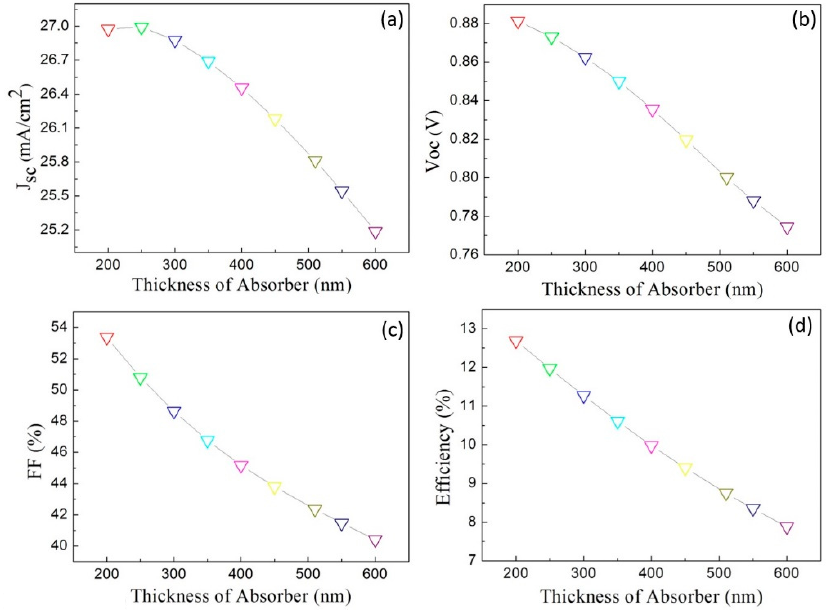
Figure 4. Thickness effect of the absorber layer on the ( a ) J sc , ( b ) V oc , ( c ) FF and ( d ) efficiency of the solar cell.